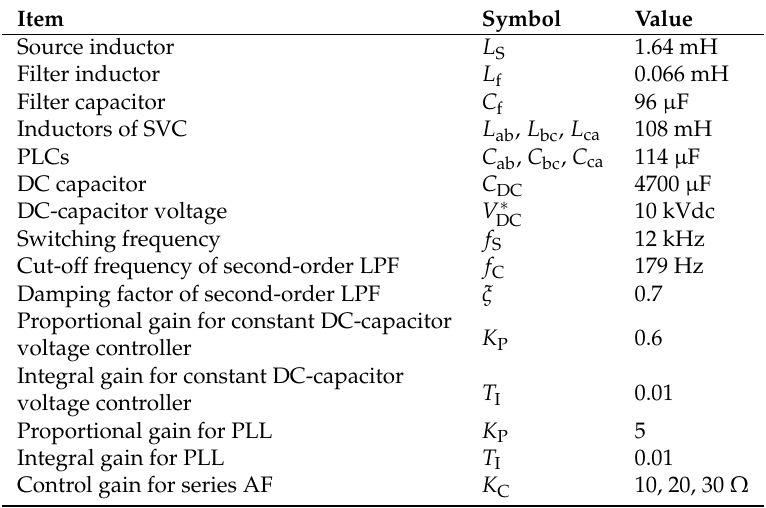
Figure 4. Circuit diagram of the proposed hybrid static VAR compensator (SVC) with a series active filter (AF). Table 2. Circuit Constants for Figure